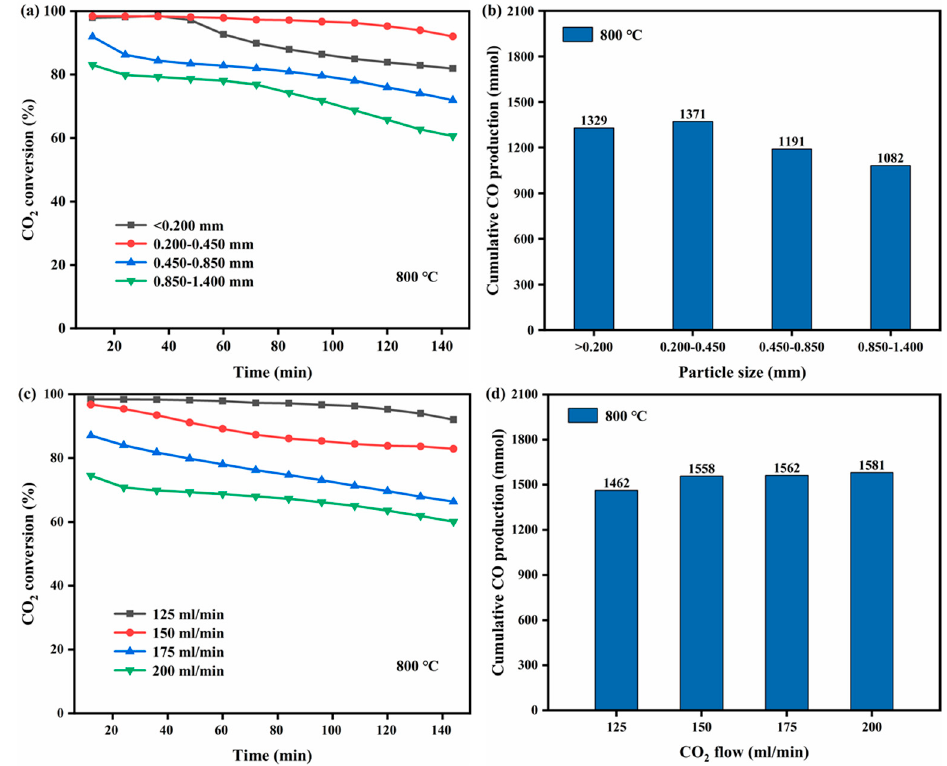
Figure 3. ( a ) Effect of SC particle size on CO 2 conversion; ( b ) CO output at different particle sizes. Reaction conditions: the CO 2 flow was 125 mL/min, the reaction temperature was 800 ◦ C, the reaction time was 144 min; ( c ) Effect of gas flow rate on CO 2 conversion; ( d ) CO output at different gas flow rates. Reaction conditions: the SC particle size was 0.200–0.450 mm, the reaction temperature was 800 °C, the reaction time was 144 min.